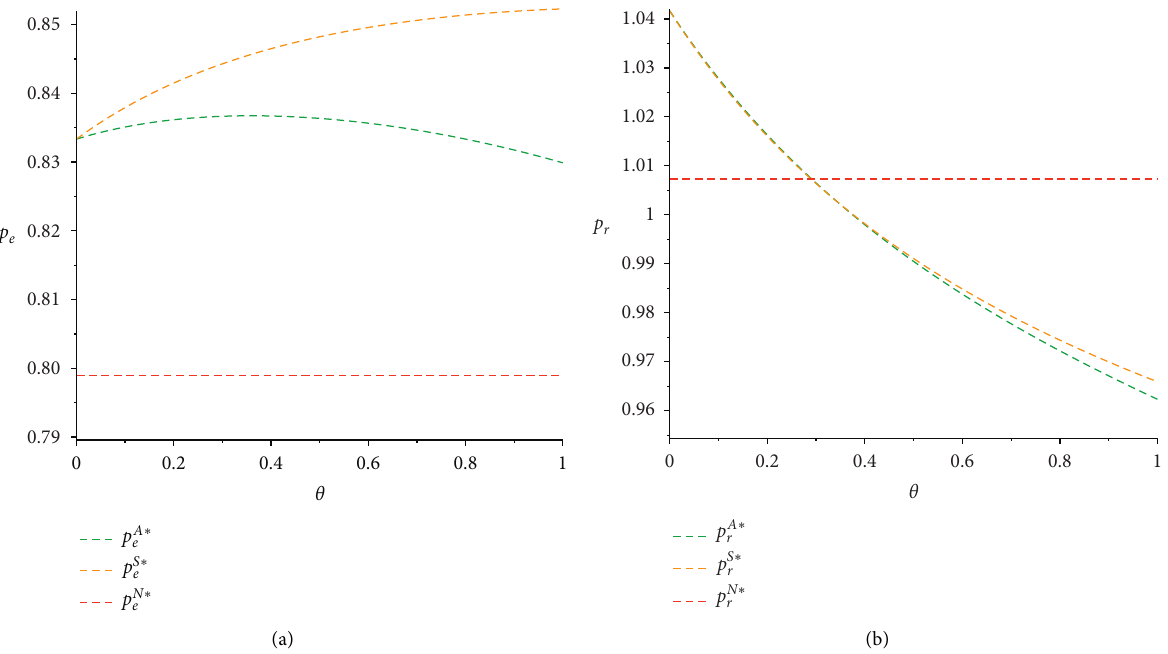
Figure 4: Comparison results of prices versus parameter θ when a � 0 . 5, b � 0 . 2, and c � 0 . 8 three models. (b) Equilibrium prices of regular channel under three